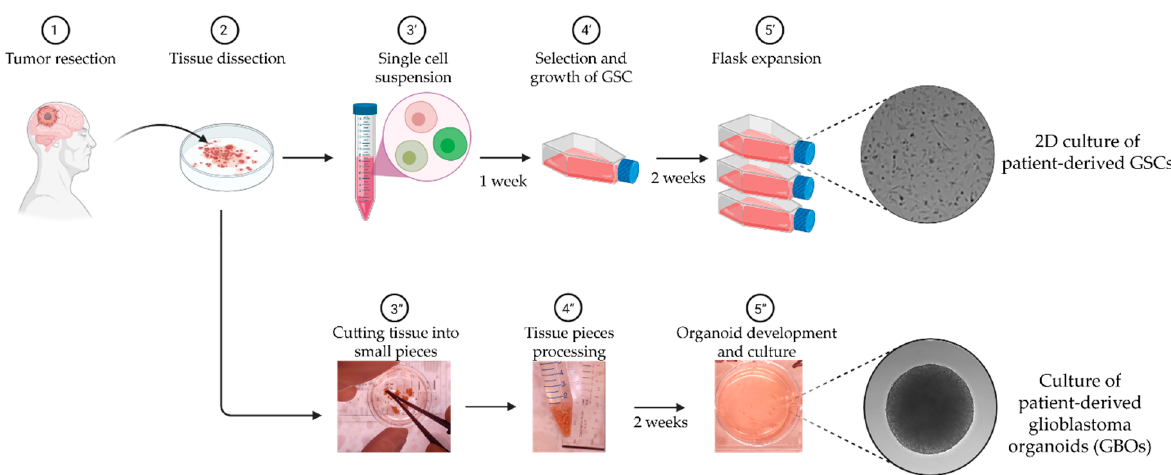
Figure 1. Patient derived in vitro models of glioblastoma used in this study. Following surgical resection, the tissue sample is dissected and streamed into two workflows: ( ′ ) the generation of two dimensional (2D) culture of low passage patient- derived glioma stem cells (GSCs); and ( ″ ) the culture of three dimensional (3D) patient-derived glioblastoma explant organoids (GBOs). Key steps (3–5) for each workflow are mentioned and the gray-background images correspond to DIC microscopy images.